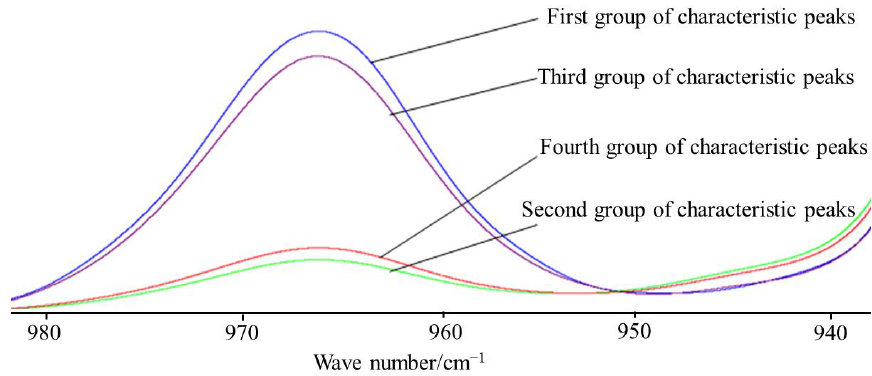
Figure 2. Infrared spectra of different types of SBS-modified asphalt with 4% content at 966 cm − 1 .